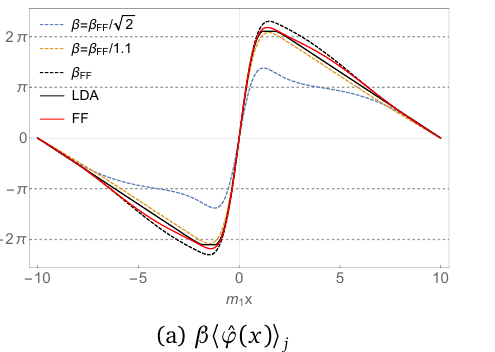
Figure 4.3: Comparing the quantum initial state to the exact free fermion and LDA results, with (a) showing the quantum expectation value of the field, while (b) dis- plays the expectation value of the topological charge density together with the asymp- totic value of j (cid:48) ( ± L / 2 ) / ( 2 π ) with horizontal grey dashed line. The parameters are (cid:96) = m / m = 18, m σ = 2 / 3. Blue, orange and black dashed curves L = 20, A β (cid:112) 1 FF 1 1 / / 1.1 and β = β are extrapolated TCSA data for β = β 2, β (free fermion FF FF FF point), while continuous black and red lines correspond to the LDA and the exact free fermion computation. For β = β the breather mass m is taken as twice the FF 1 soliton / fermion mass. TCSA profiles of 〈 ˆ ρ ( x ) 〉 were extrapolated using cut-offs j = 24,26,28 and 30. In all cases, the corresponding profiles for β 〈 ˆ ϕ ( x ) 〉 e were c j = β 〈 ∂ ˆ ϕ ( x ) 〉 obtained by spatial integration of 2 π 〈 ˆ ρ ( x ) 〉 , fixing the zero mode by j x j requiring the result to vanish at the origin x =